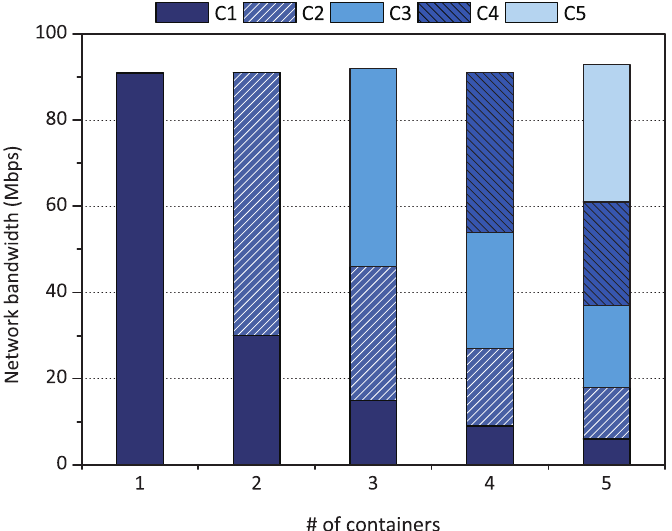
Figure 8. Proportional share scheduling evaluation results of qCon when the number of containers running concurrently increased from one to five (weight set was 1 to 5